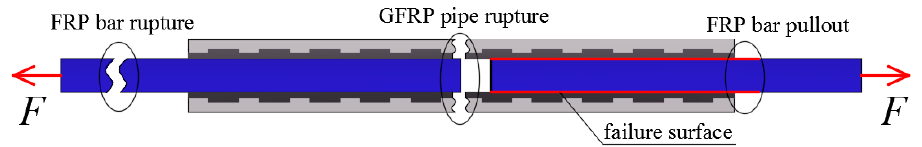
Figure 2. Failure modes of FRP bars spliced with the proposed connection system.